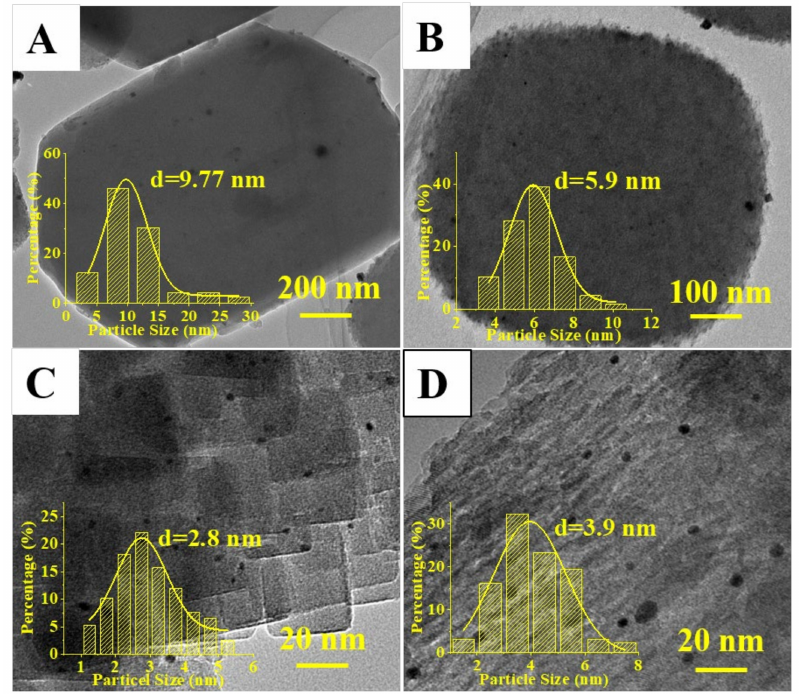
Figure 2. TEM images of ( A ) Pt / CZ, ( B ) Pt / Z-400, ( C ) Pt / Z-40, and ( D ) Pt / NS-2 catalysts.